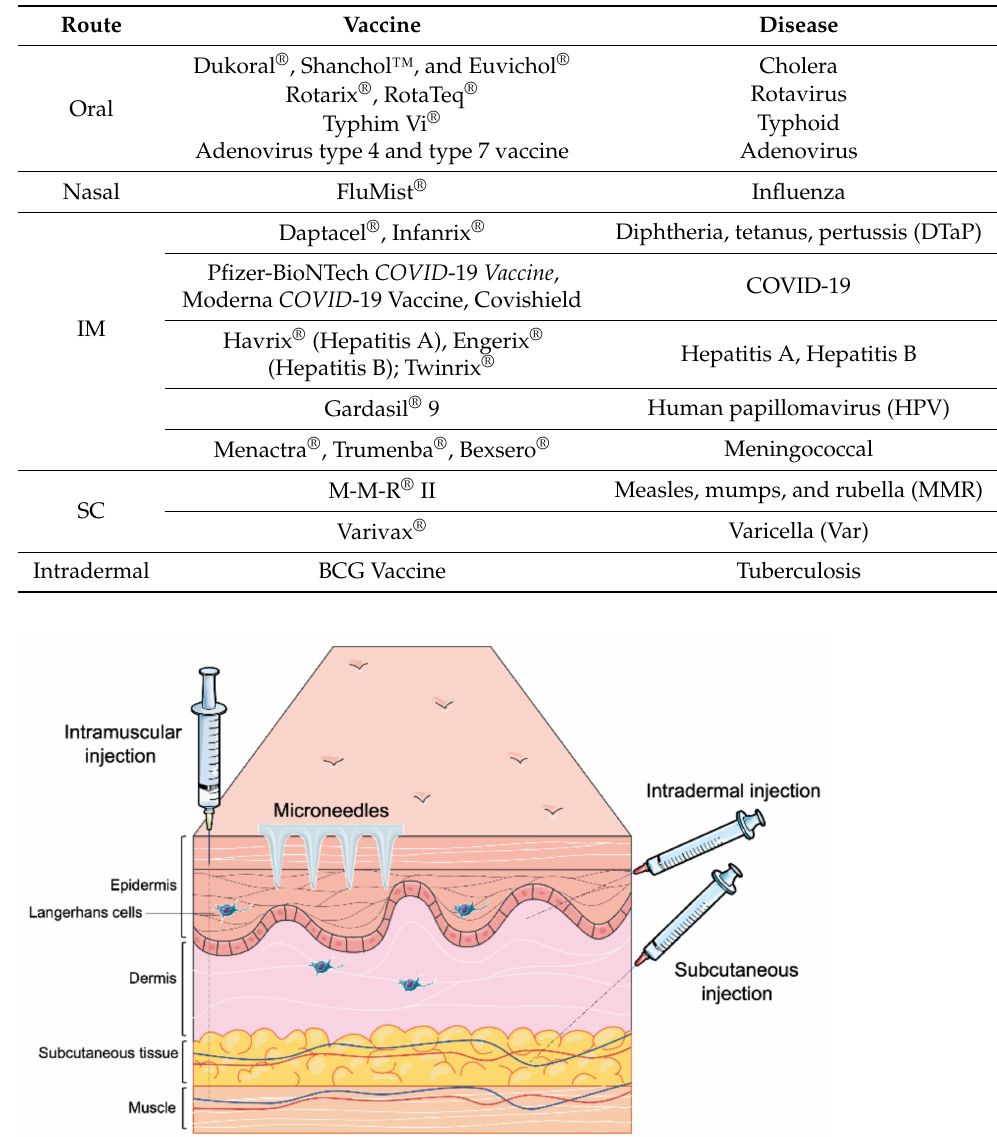
Table 1. Diseases, Marketed Vaccines, and their routes.